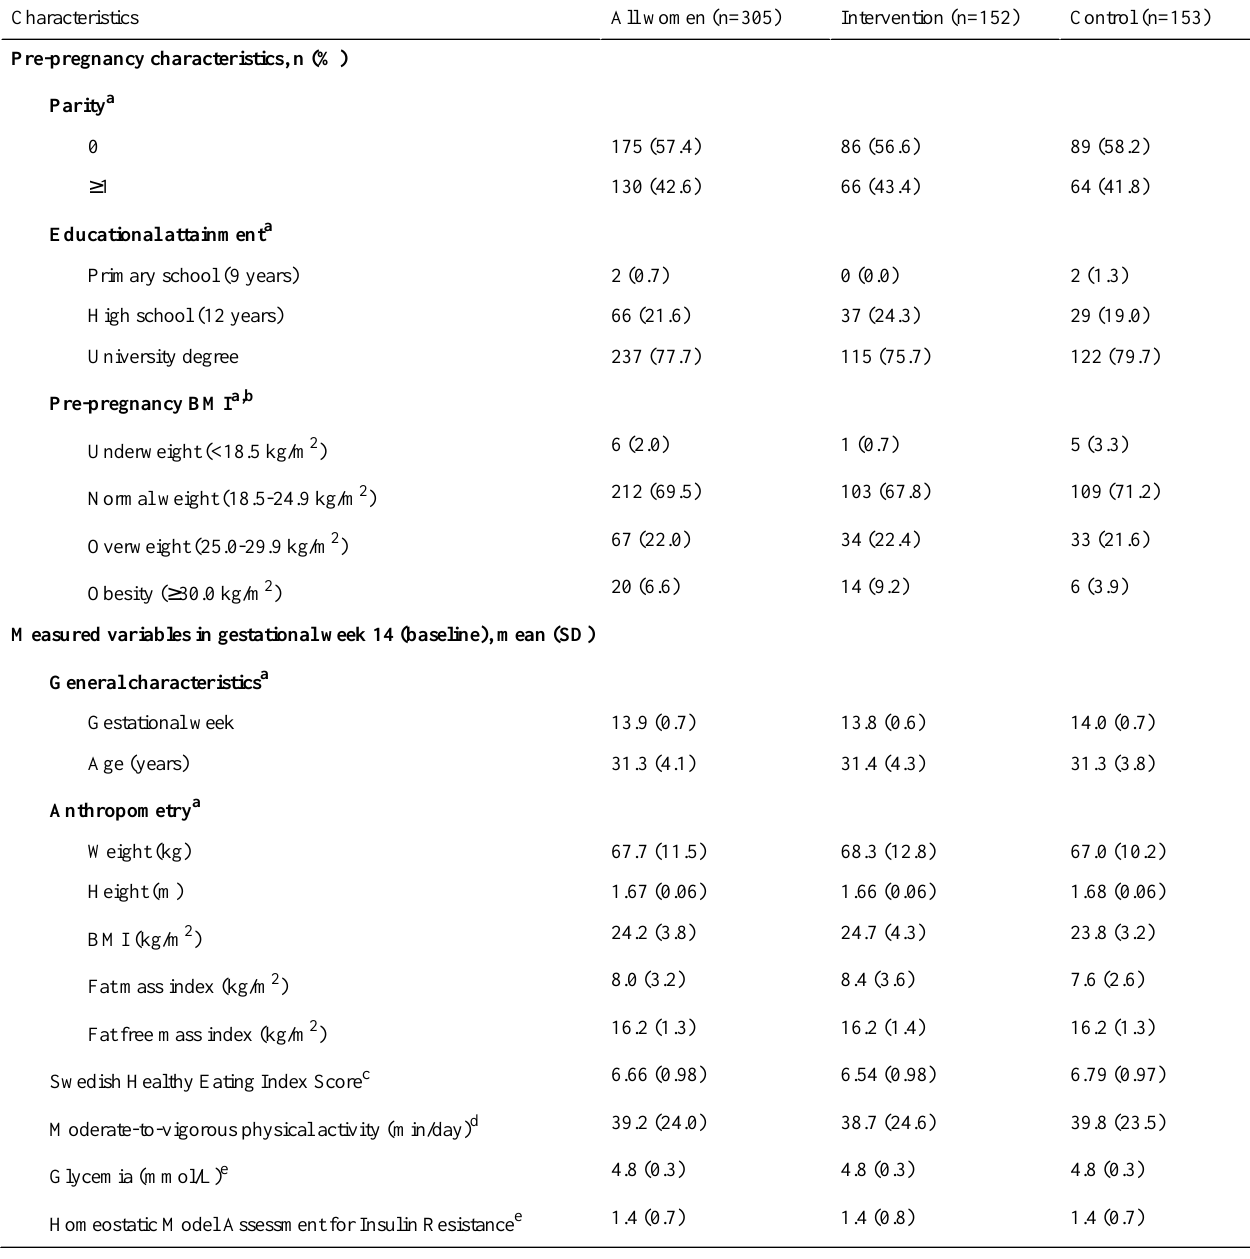
Table 1. Baseline characteristics of the women in the HealthyMoms